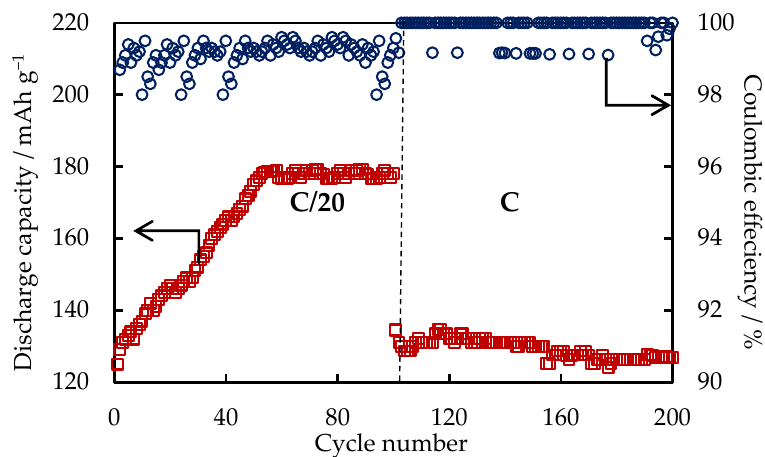
Figure 8. Changes in the discharge capacity and Coulombic efficiency of the SiC sample during cycling at a current of C/20 and C.